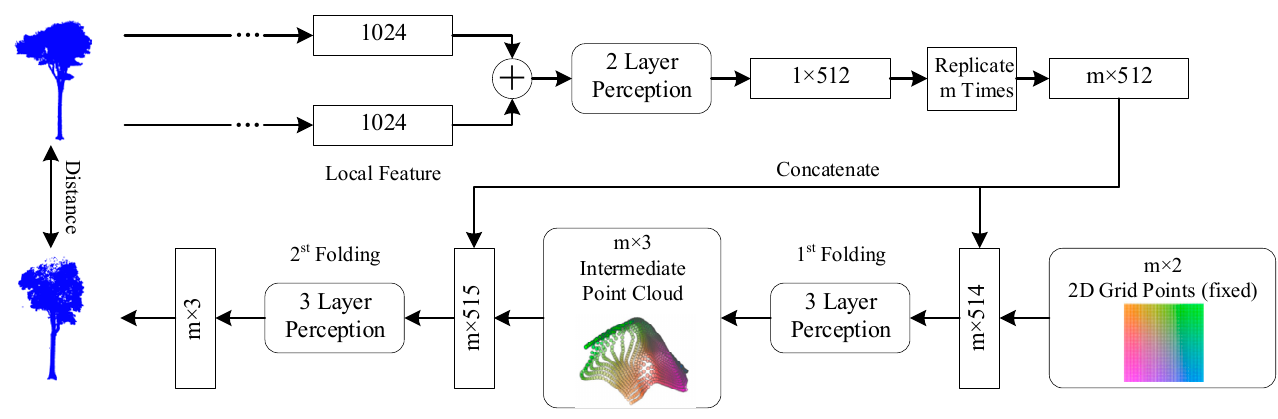
Figure 5. Architecture of point cloud generation network.